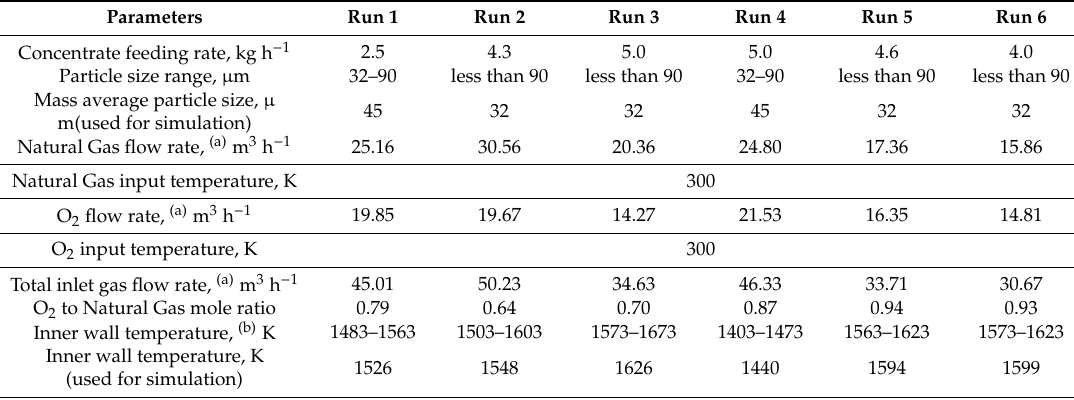
Table 5. Experimental conditions of the